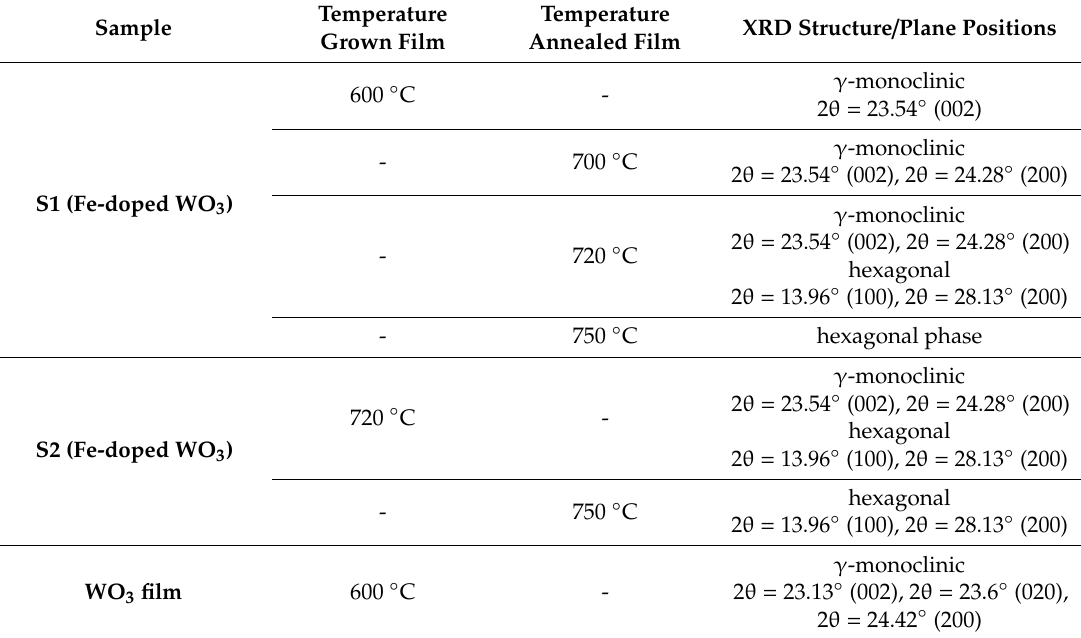
Table 1. The structure and temperature of S1, S2 film samples and WO 3 ,